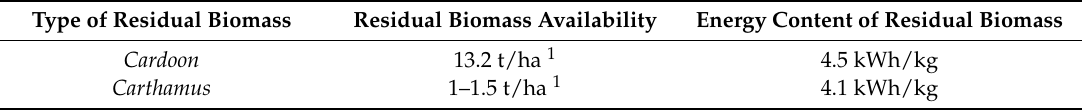
Table 1. Average values of the cardoon and Carthamus growing yield for a hectare per year (provided by project partners within the BIT3G project) and their energy content (measured at the CRB/CIRIAF Lab).